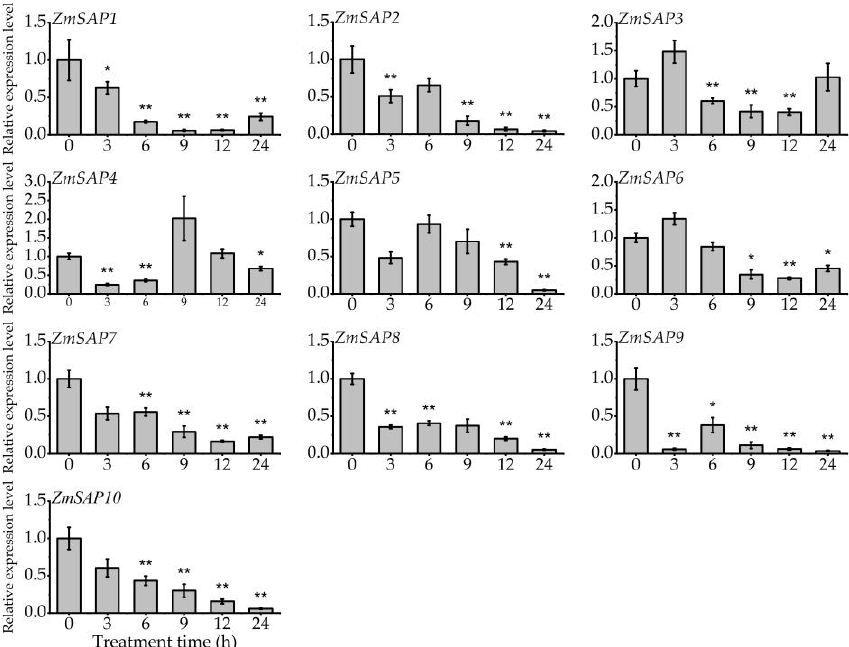
Figure 7. The expression of ZmSAP s under salt stress by 250 mM NaCl treatment. * and **, indicates significant differences at p < 0.05 and p < 0.01, respectively.